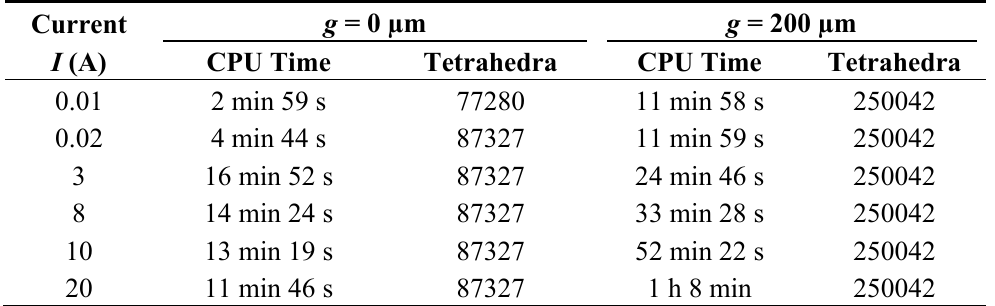
Table 2. Computational cost for the 3D simulations as a function of the DC excitation current I (A).